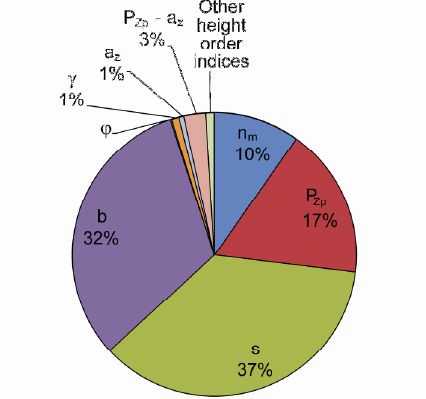
Fig. 20. Results for the fourth terrace ( P p is a non-random